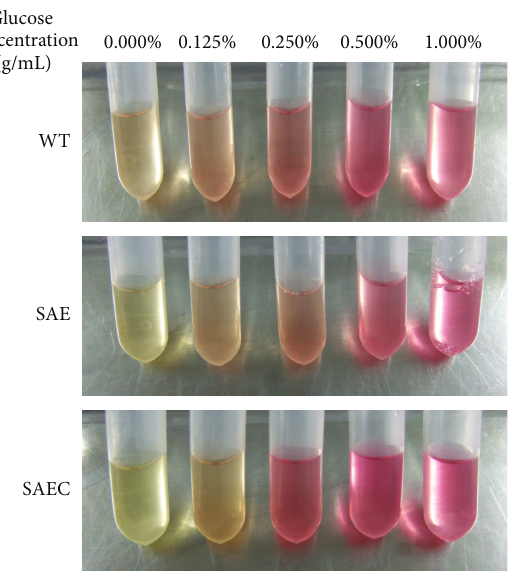
Figure 7: Methyl red test. SAE, WT, and SAEC were grown with or without 0.125%, 0.25%, 0.5%, and 1% (g/mL) glucose for 24 h. Five drops of methyl red were added to the culture supernatant and then gently rolled to disperse the methyl red. The supernatant will turn yellow at neutral pH but turn red at pH <